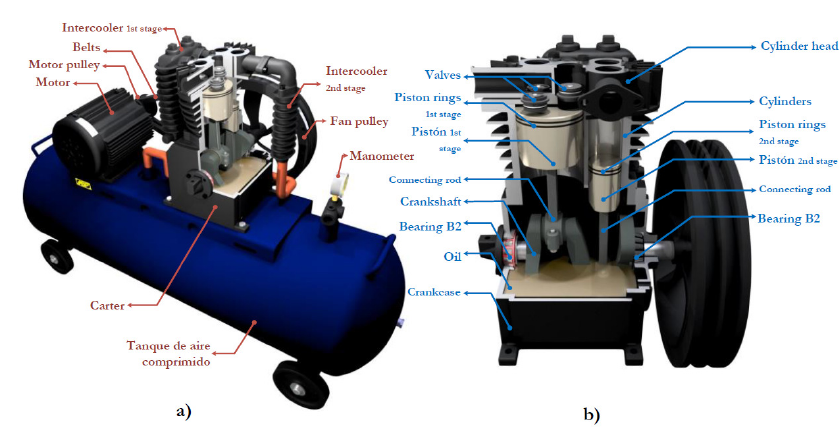
Figure 12. EBG250 compressor: ( a ) external parts; ( b ) An internal view of the